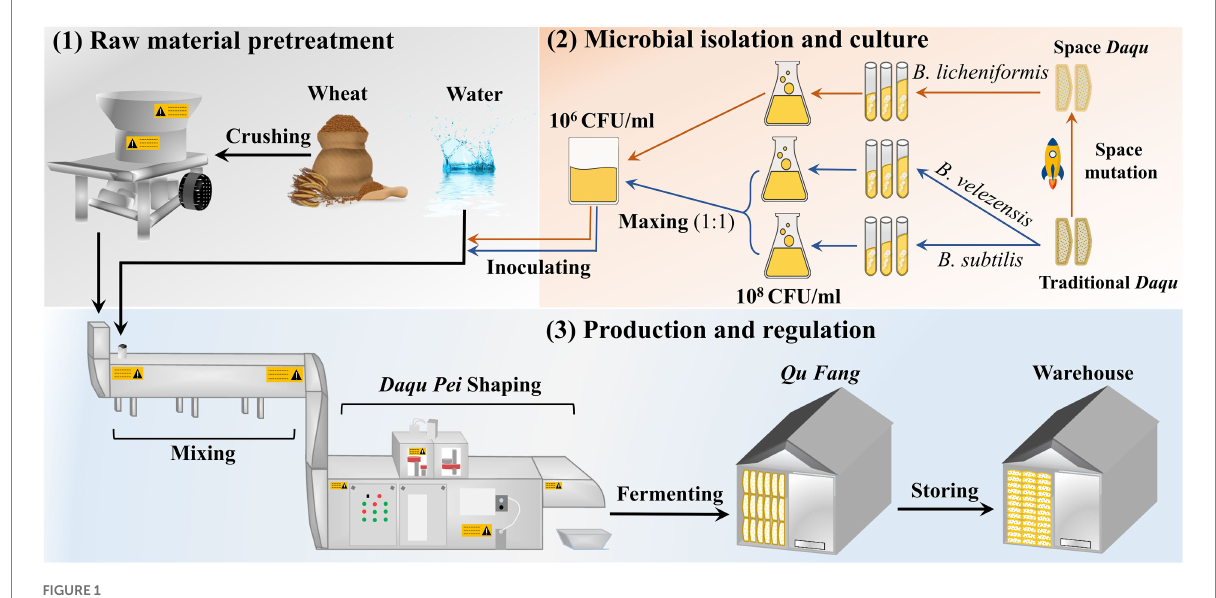
FIGURE 1 The manufacturing process of the medium-temperature Daqu